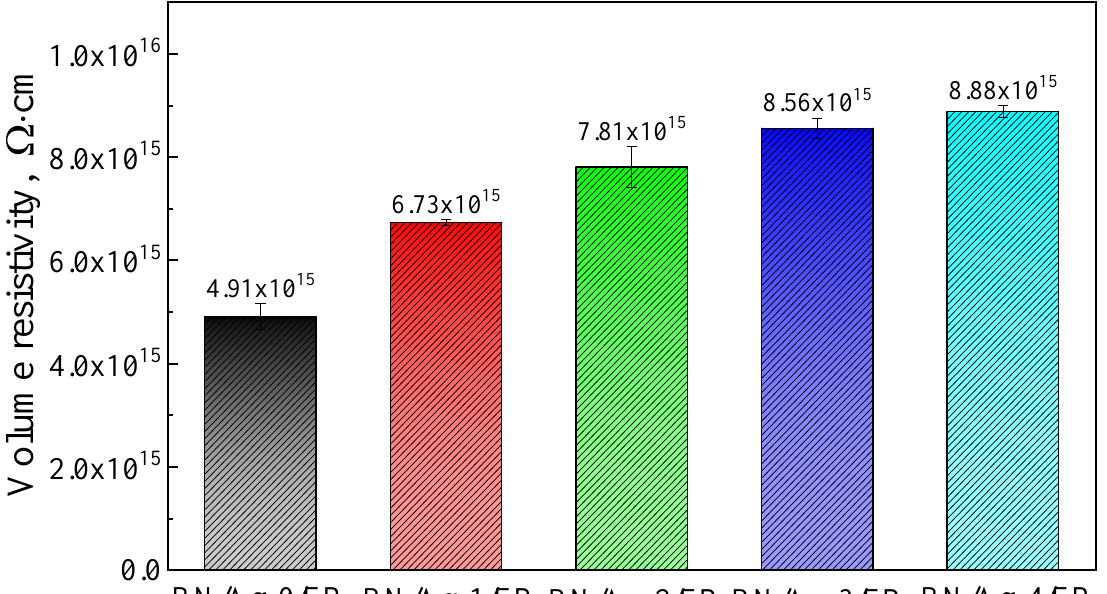
Figure 10. Volume resistivity of BN/AgNWs/EP Composites.